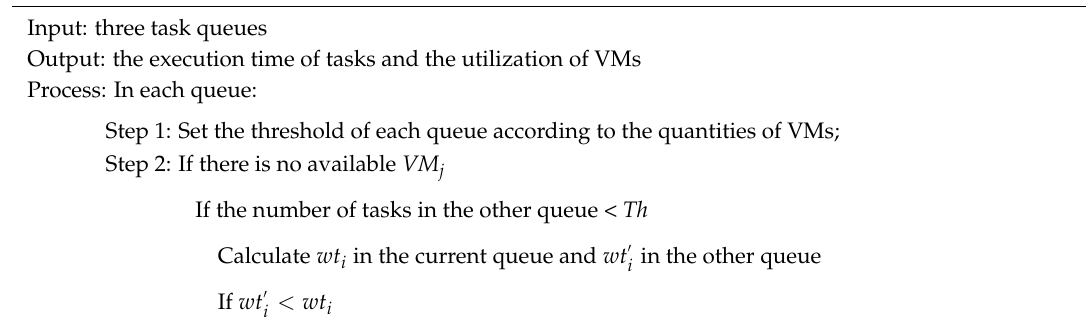
Algorithm 4. The procedure of improved FIFO algorithm